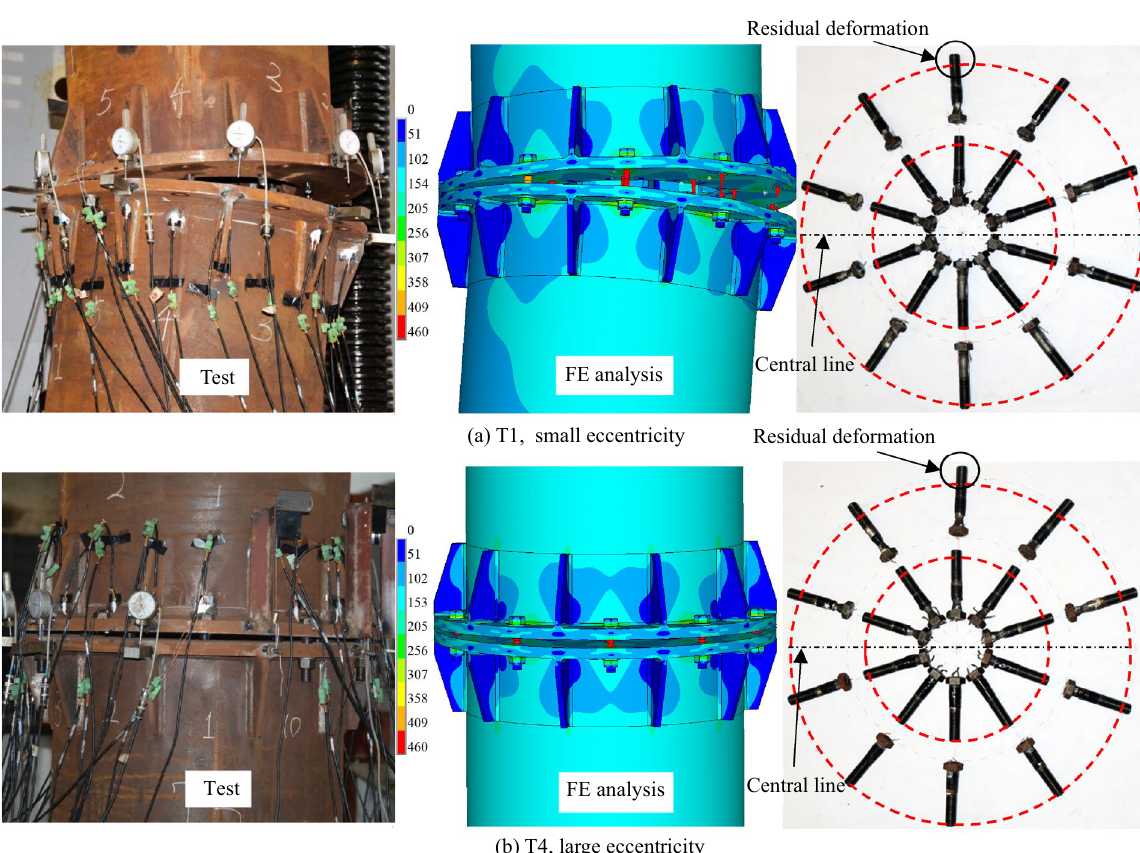
Figure 14. Failure modes of